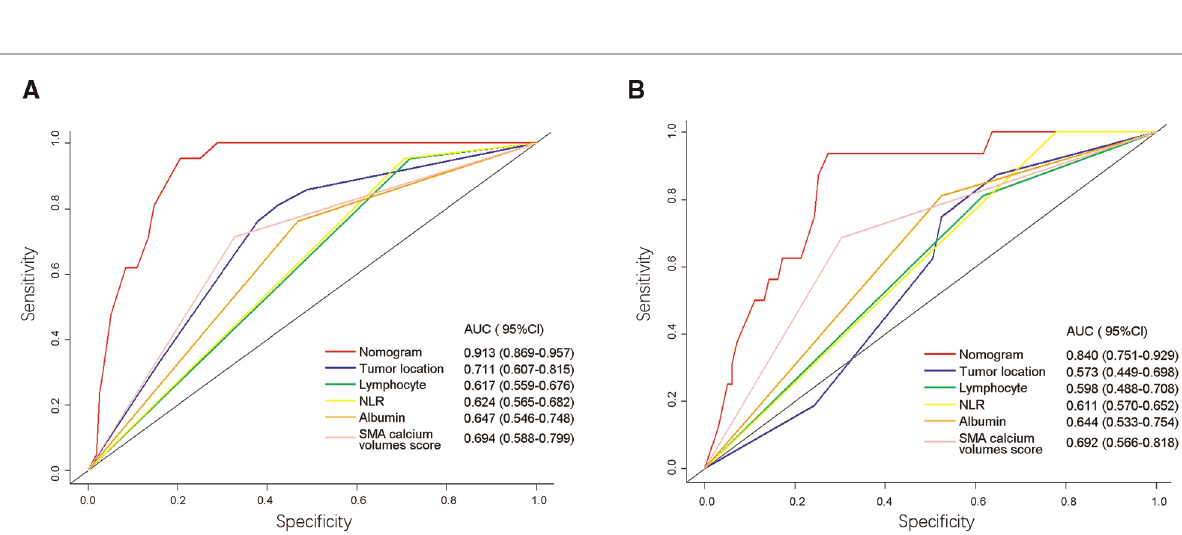
FIGURE 6 Receiver operating characteristic (ROC) curves of the nomogram and fi ve risk factors in training cohort ( A ) and validation cohort ( B ). The values of AUC (95%CI) for the nomogram and fi ve risk factors were listed in the fi gure. The X -axis represented the speci fi city of the nomogram and fi ve risk factors to predict AL, and the Y -axis represented the sensitivity of these items. NLR, neutrophil-lymphocyte ratio; SMA, superior mesenteric artery; AUC, area under the